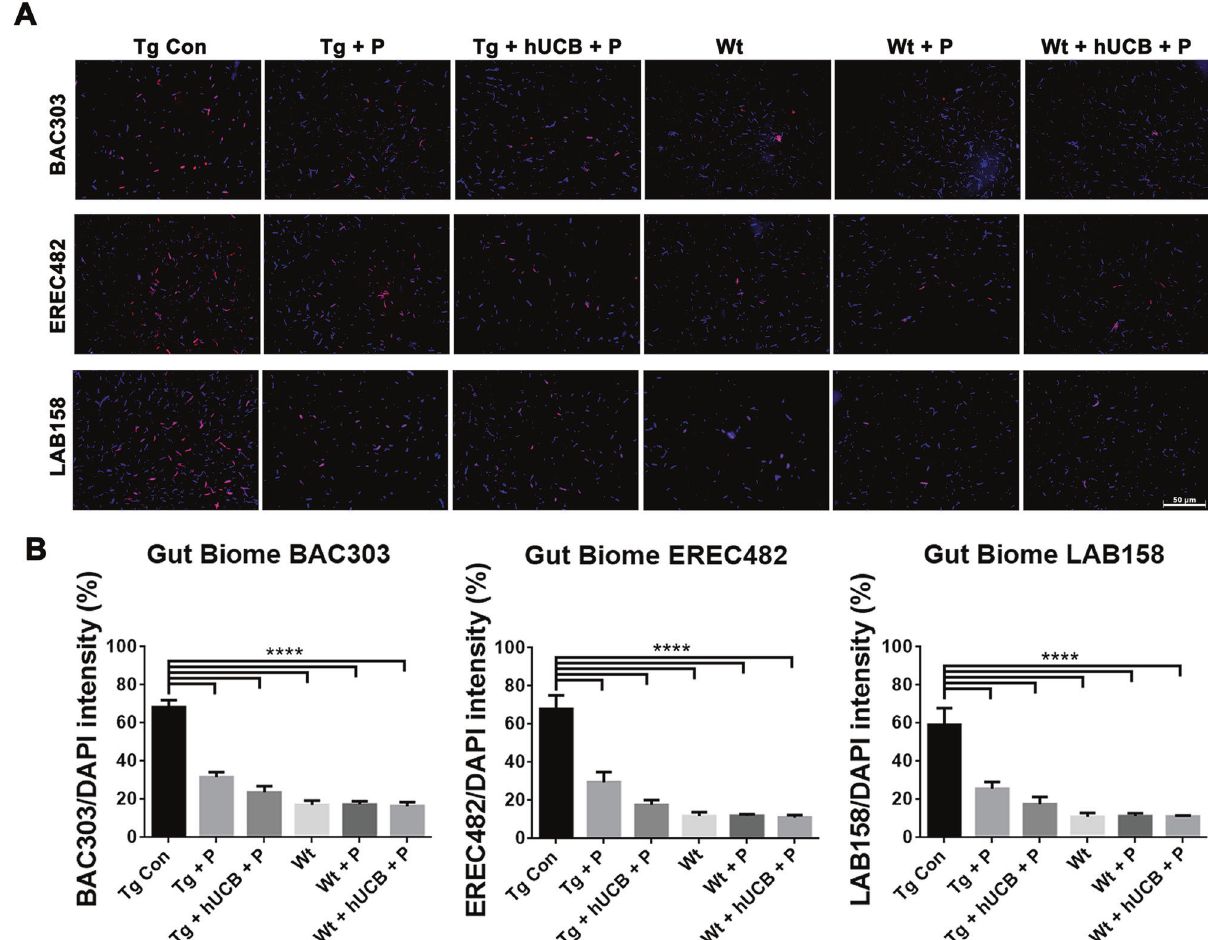
Fig. 2 Gut microbiome differences in PD mouse model. A FISH analysis was used to distinguish the speci fi c microbiota within the feces of the animals using probes for BAC303 (red), EREC482 (red), and LAB158 (red) with DAPI (blue). Immuno fl uorescent microscopy was used to collect the images of representative samples from each animal group (Scale bar = 50 um). B Differences in gut biome was measured for signi fi cance for each group by calculating probe fl uorescence intensity/DAPI. ANOVA revealed signi fi cantly elevated BAC303 levels (**** p < 0.0001), EREC482 levels (**** p < 0.0001), and LAB158 levels (**** p < 0.0001) in Tg control groups compared to both treatment groups and Wt animals (**** p <